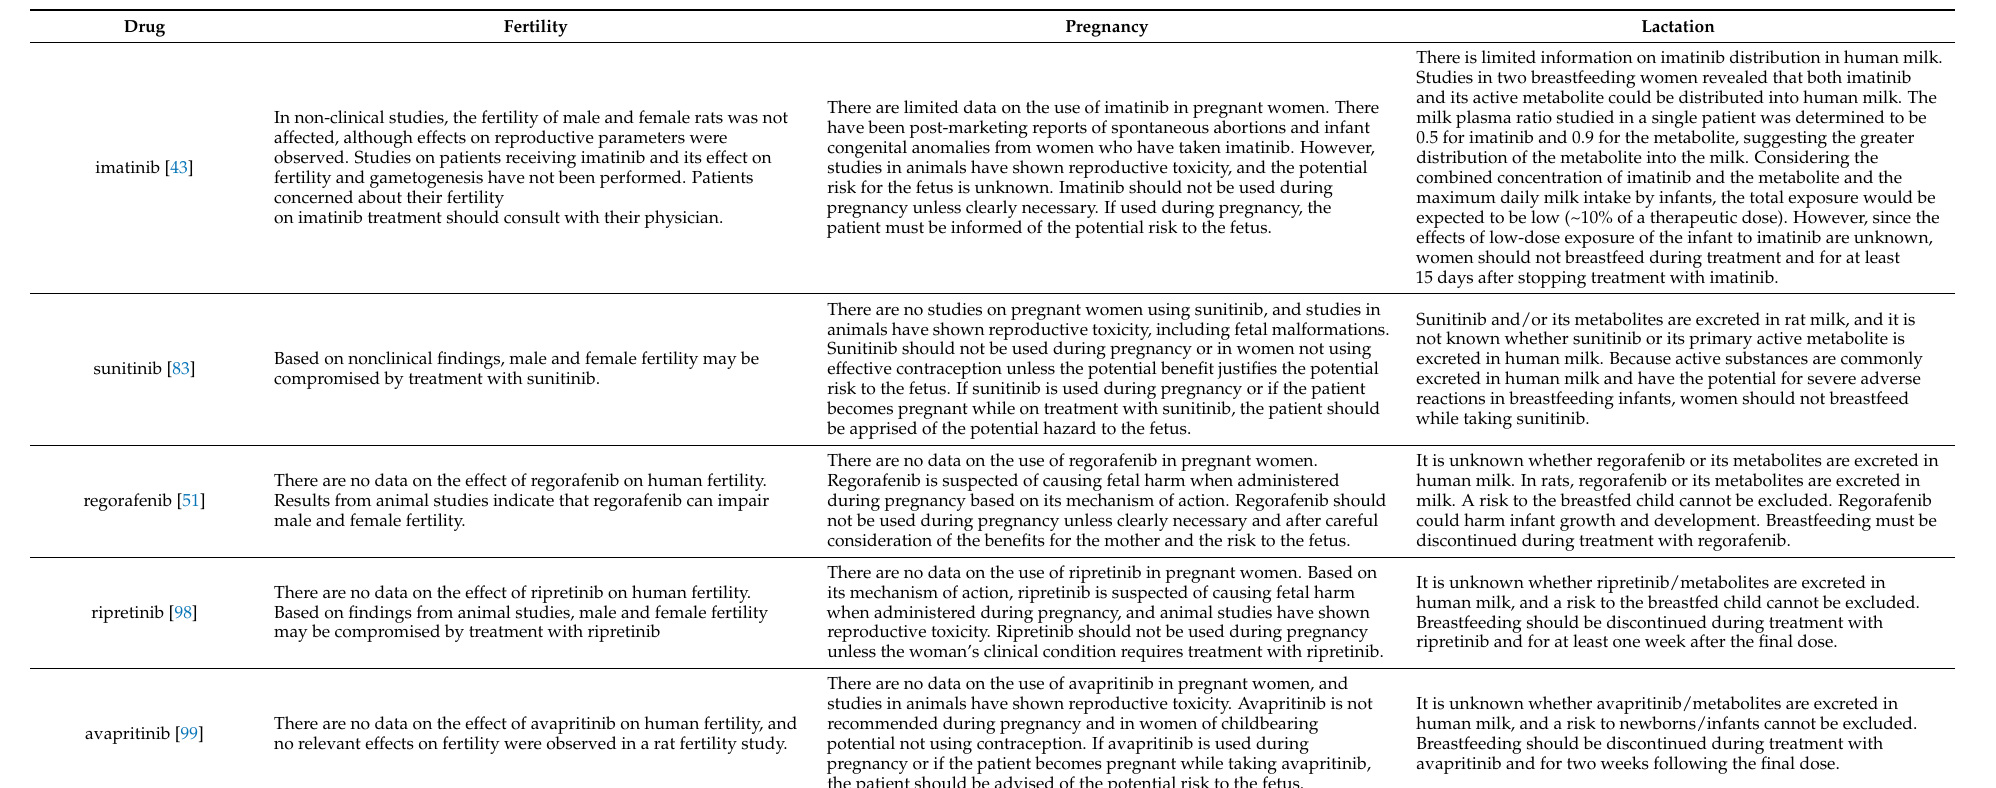
Table 4. The effects of anticancer treatment for GISTs on fertility, pregnancy, and